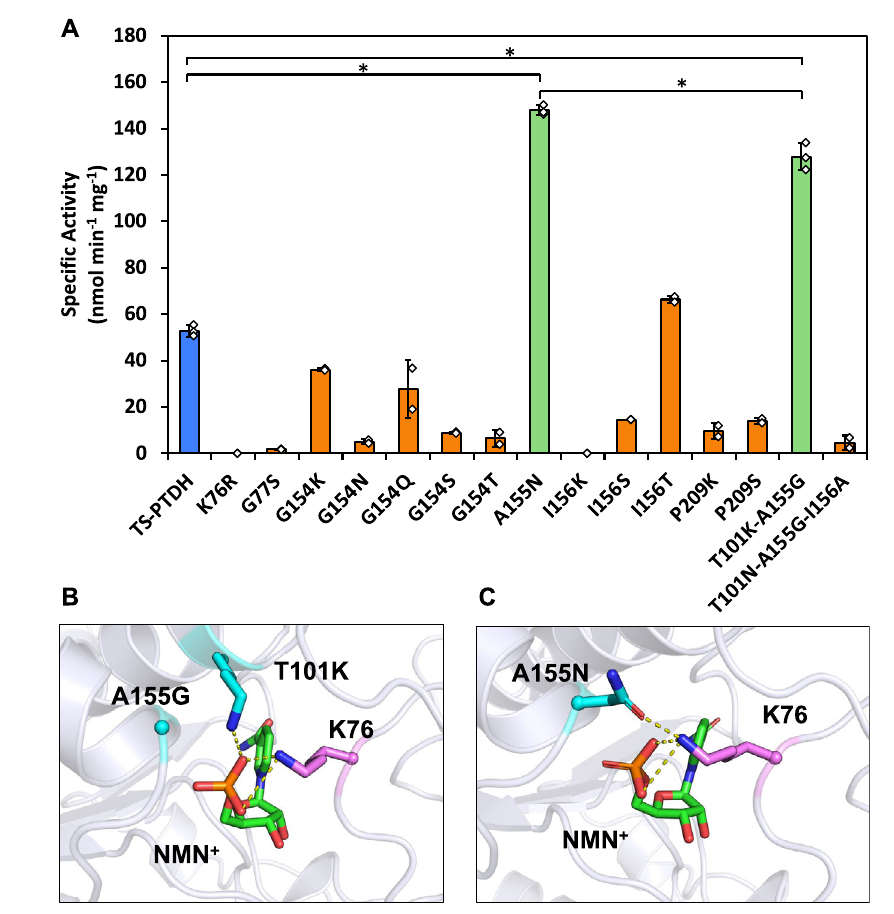
Fig. 2 | First round of TS-PTDH variants engineered through rational design. A Twomutants(green)displayedspeci fi cactivitieswithNMN + notablygreaterthan the wild type (blue). A155N showed ~3-fold increase and T101K-A155G showed a ~2- fold increase compared to the wild type. For TS-PTDH, A155N, and T101K-A155G, n =3 biologically independent replicates. For other candidates, n =2 biologically independent replicates. For statistics, TS-PTDH to A155N, P =9×10 − 7 ; TS-PTDH to T101K-A155G, P =0.0004; A155N to T101K-A155G, P =0.018. B Molecular modeling of the designs suggestthatT101K-A155Gfunctions throughthecooperative effects